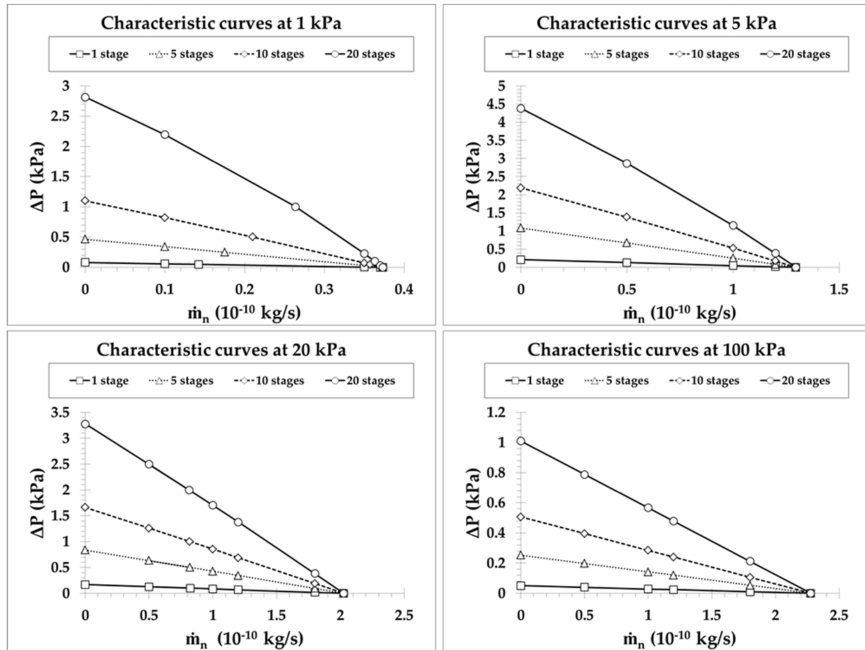
Figure 9. Performance characteristic curves of a Knudsen pump, based on pump C, for a number of stages N = 1,5,10,20 with inlet pressures P in = 1,5,20,100 kPa when narrow microchannels diameter d = 10 µ m and wide channel diameter D = 100 µ